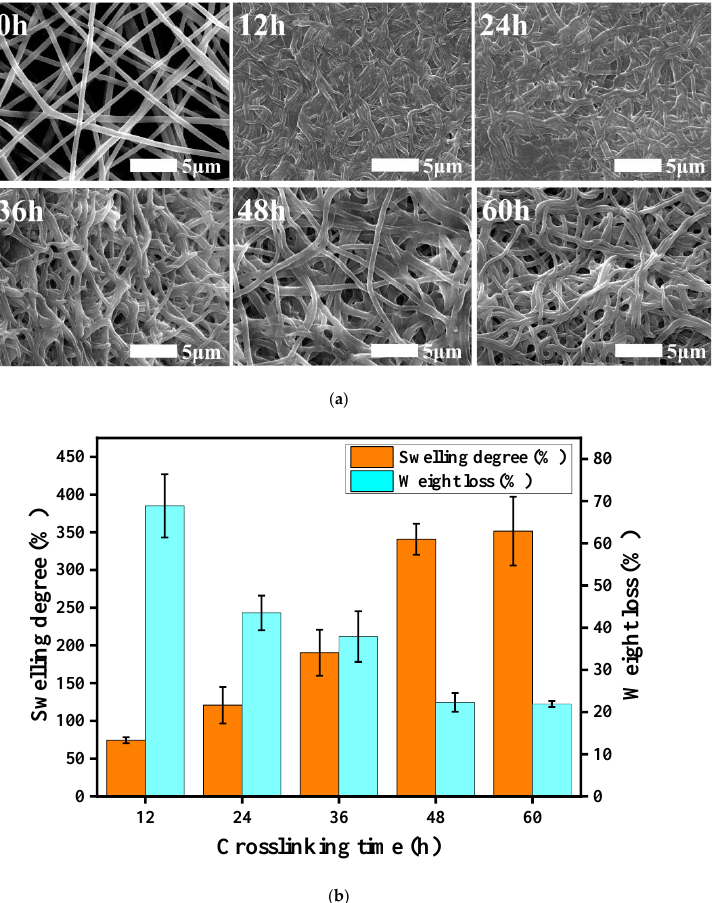
Figure 3. ( a ) SEM images of γ -PGA/keratin fiber membranes at different treatment times; ( b ) swelling degree and weight loss of ENSs under different cross-linking times. FTIR spectra of γ -PGA and keratin blend membranes before and after cross-linking are displayed in Figure 4a. The absorption peak near 3290 cm − 1 was attributed to the overlapping of N-H and O-H stretching vibrations. The absorption peaks at 1676 cm −1 and 1540 cm − 1 in the spectral picture are, respectively, the vibration absorption peaks of amide I and amide II bands [42]. It can be observed from Figure 4a that a new character- istic absorption peak of the cross-linked fiber membrane appears at 1740 cm −1 , which is the characteristic absorption peak of the amide I band [43]. The reason for this is that the γ -PGA and amino groups in the keratin react with the carboxyl groups under the action of EDS/NHS and cystamine. The changes in the FTIR spectra clearly indicate that EDC/NHS/cystamine was successfully cross-link ed with γ -PGA and keratin.